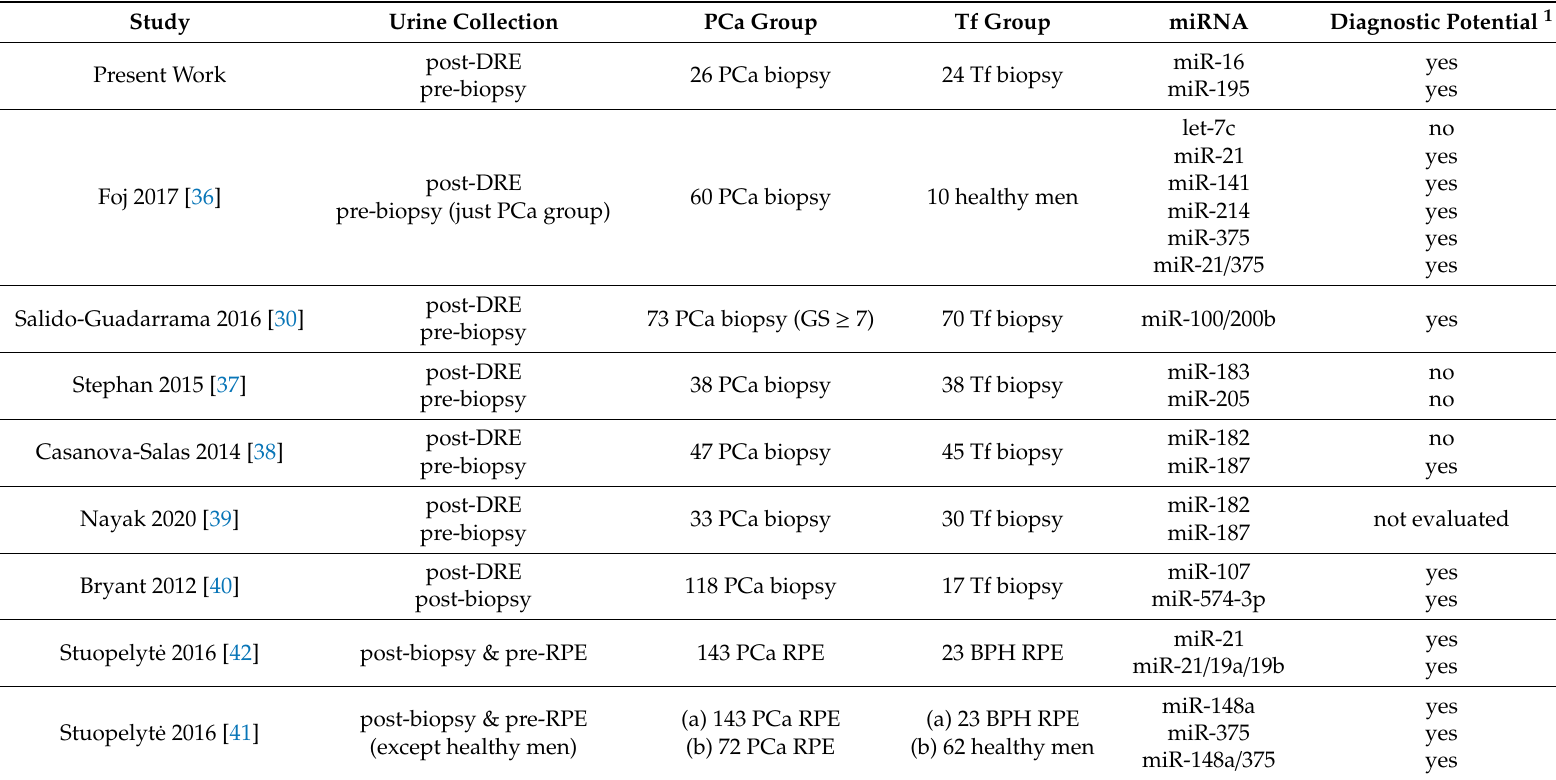
Table 5. Overview of selected studies including the present work investigating miRNAs in urinary cells as diagnostic markers for